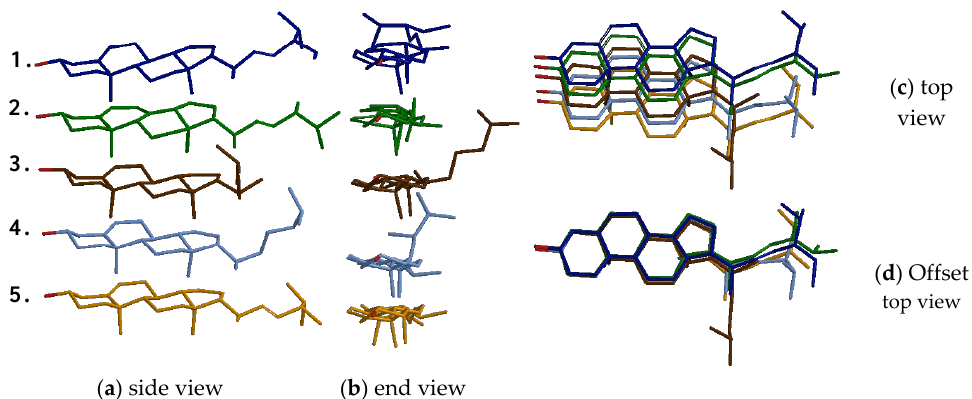
Figure 4. Density functional equilibrium geometry models of five different sterol compounds shown in ( a ) side view; ( b ) end view; ( c ) top view; and ( d ) an offset top view, where the sterol compounds are: 1. stigmasterol, 2. ergosterol, 3. cholesterol, 4. campesterol, and 5. brassicasterol, illustrating their structural similarities and differences. All models were generated using SPARTAN ‘10 for Windows with the density functional equilibrium geometry calculation at the 3–21 G level.